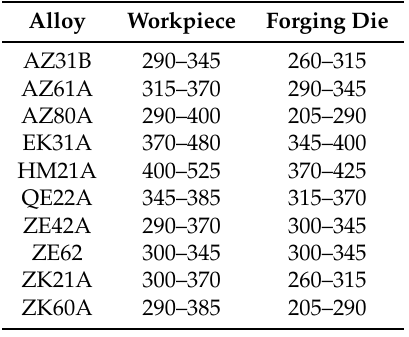
Table A3. Recommended forging temperatures for various Mg alloys in ◦ C by Reference [30].